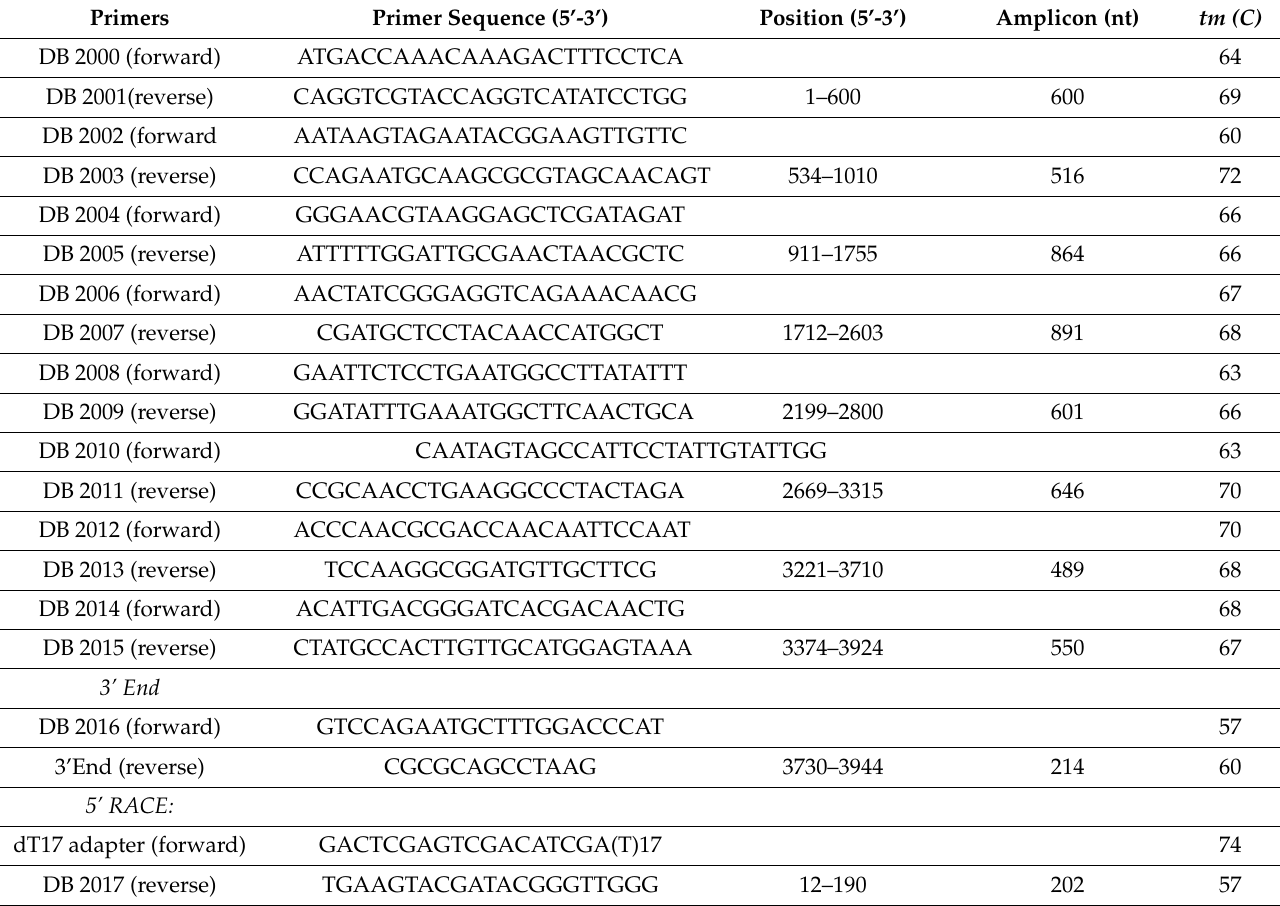
Table 1. Primers used for sequencing ABC tmf A importer cDNA from Ae.aegypti